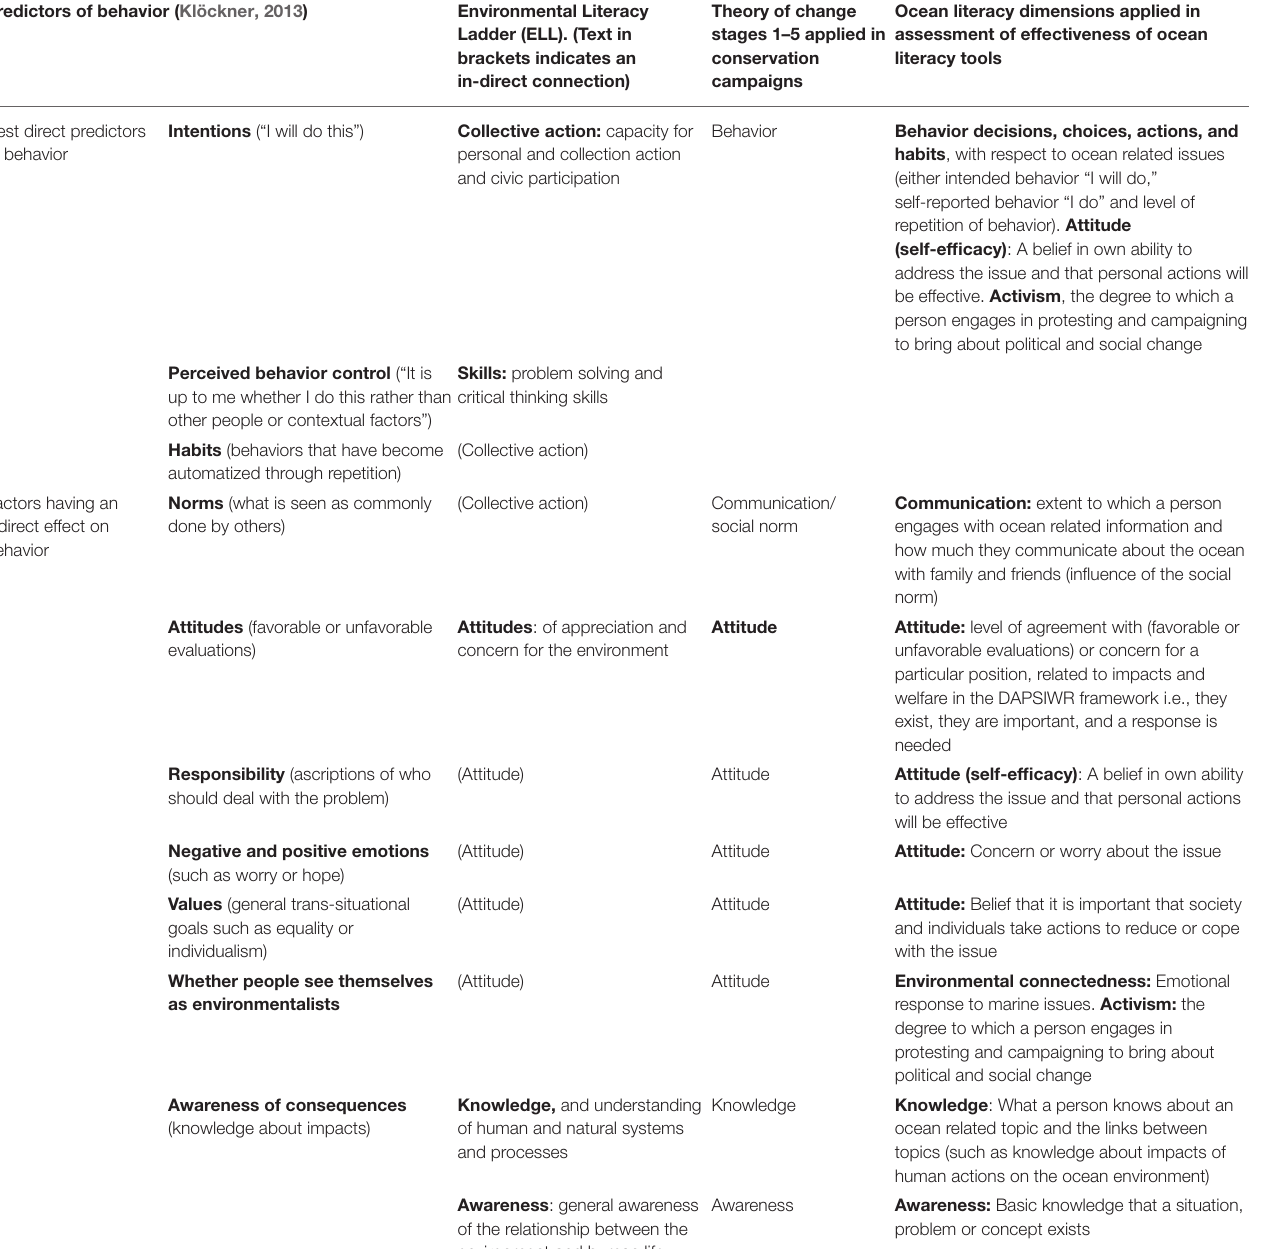
TABLE 1 | Relationship between predictors of behavior change identified by Klöckner (2013), the ELL, TofC categories, and OL dimensions applied in this study. Predictors of behavior (Klöckner,